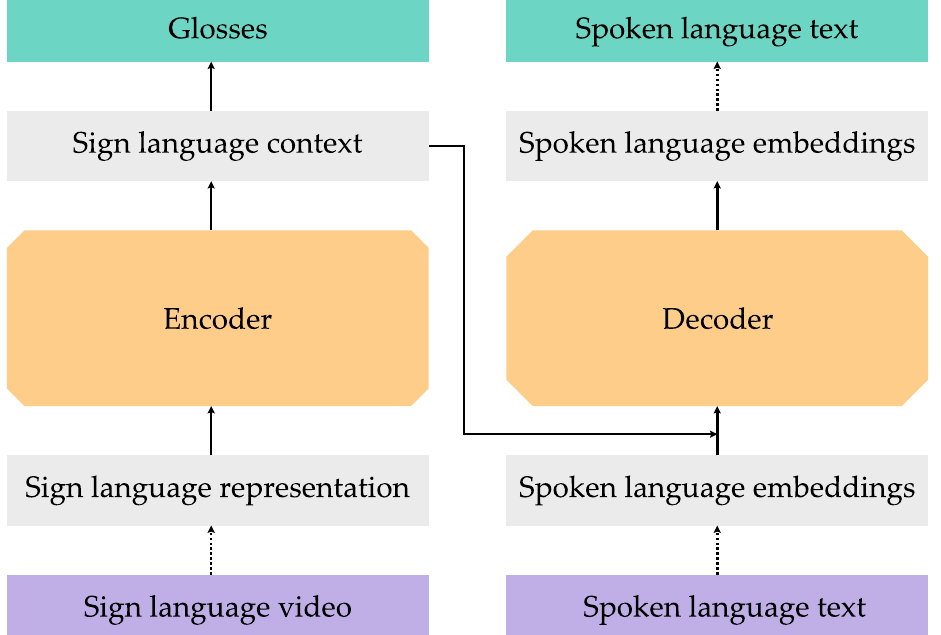
Figure 2. A neural SLT model translates from a sign language video to a written language text using an encoder–decoder model. Solid arrows indicate transformations that are trained end-to-end. Dashed arrows indicate an offline conversion: for example, the sign language videos are converted to sign language representations before training the SLT model. The gloss output (top left) is only present in a Sign2(Gloss+Text)